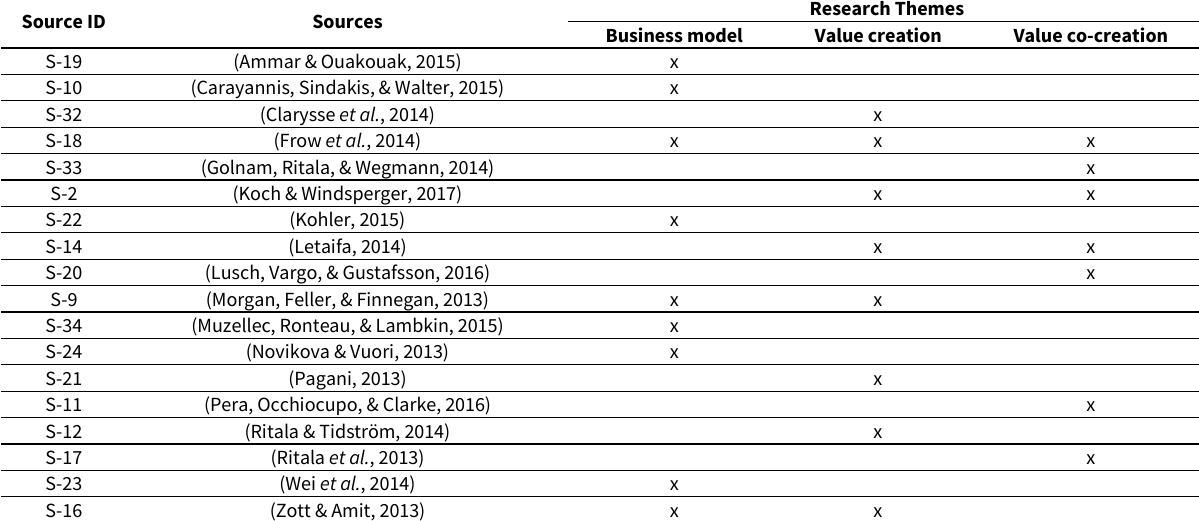
Table 8. Values co-created in